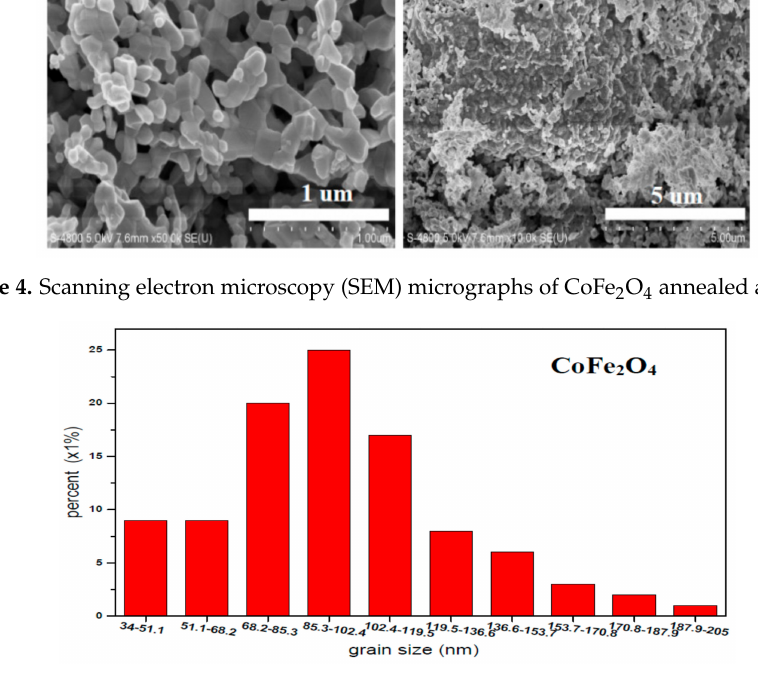
Figure 5. Histogram of grain size distribution of CoFe 2 O 4 annealed at 800 ◦